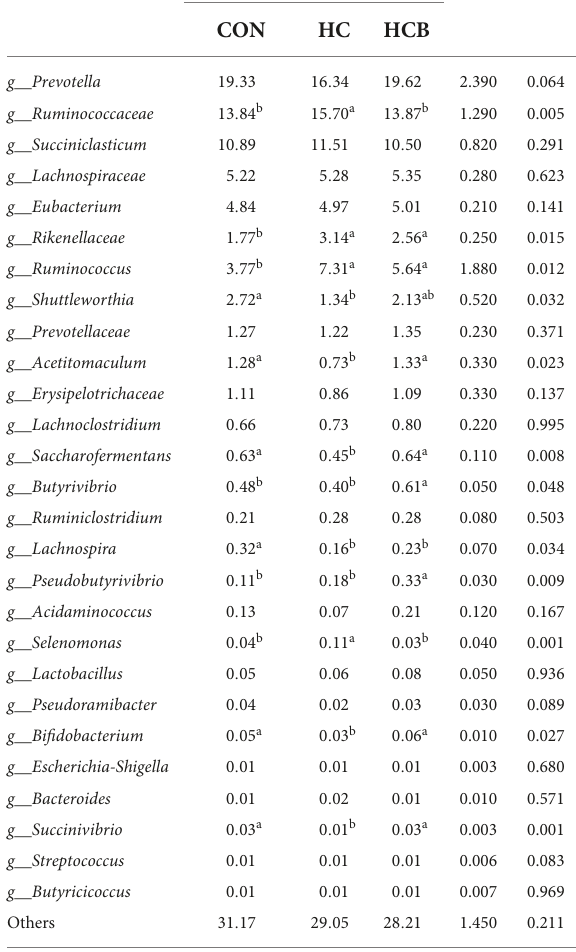
TABLE 6 Effect of high-concentrate diet feeding and thiamine supplementation on relative abundance of rumen bacteria (%, level of genera, n =